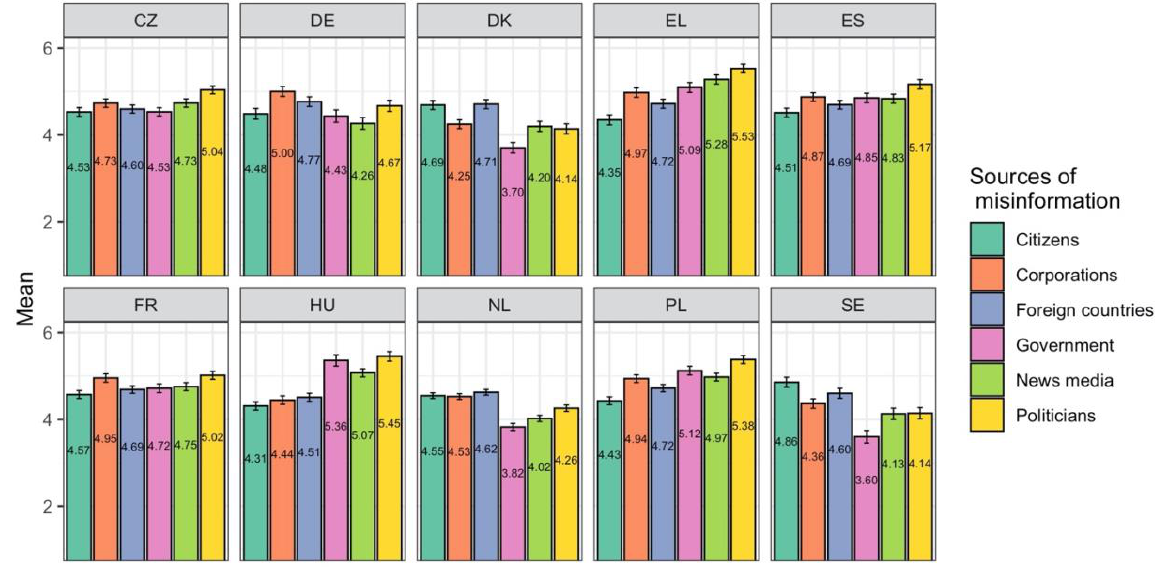
Figure A1 . Perceived misinformation sources across ten countries.